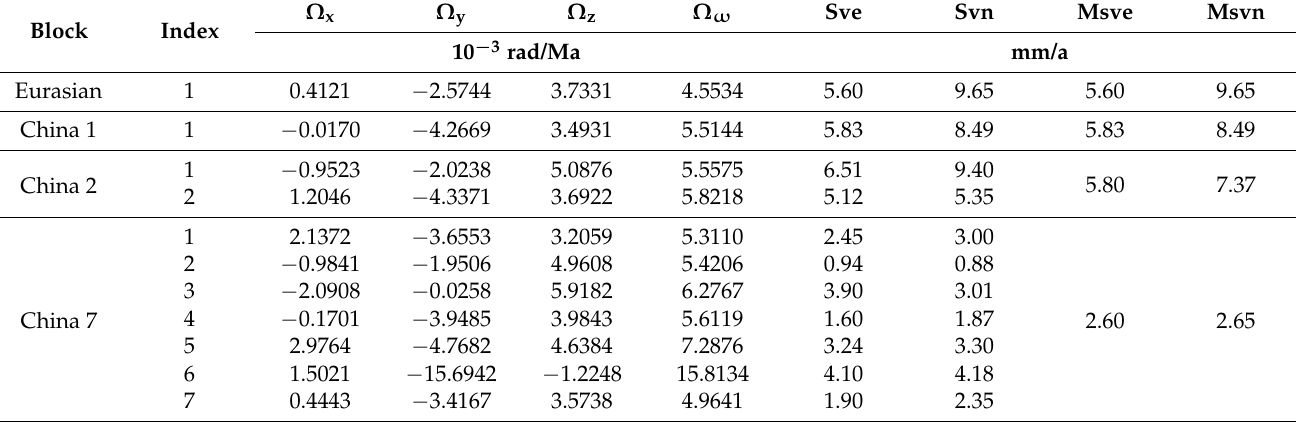
Table 2. Euler parameters and accuracy statistics of different block models in continental